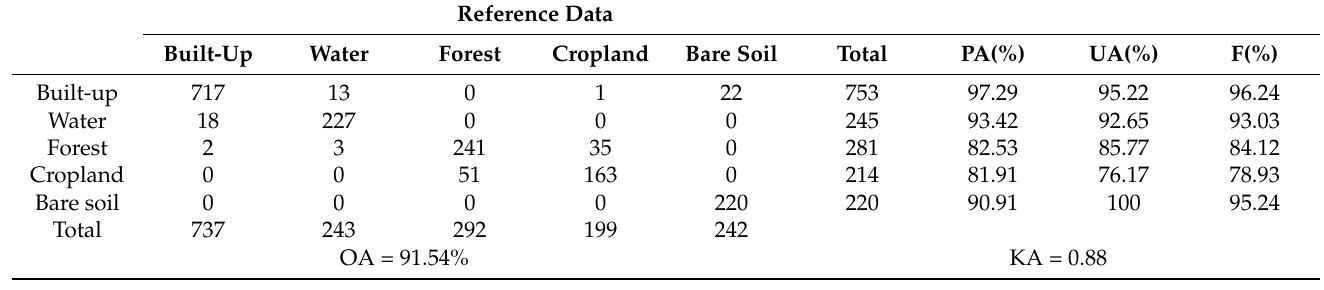
Table 2. Confusion matrix of the classification results using only the Sentinel-2B MSI data.